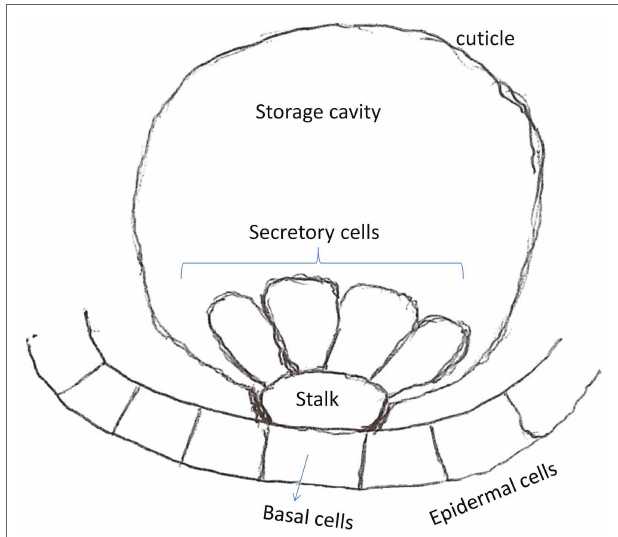
FIGURE 2 | Schematic representation of peltate glandular trichome found in Lamiaceae plants. The secretory cells produce and secret essential oil constituents into the trichome’s secretory